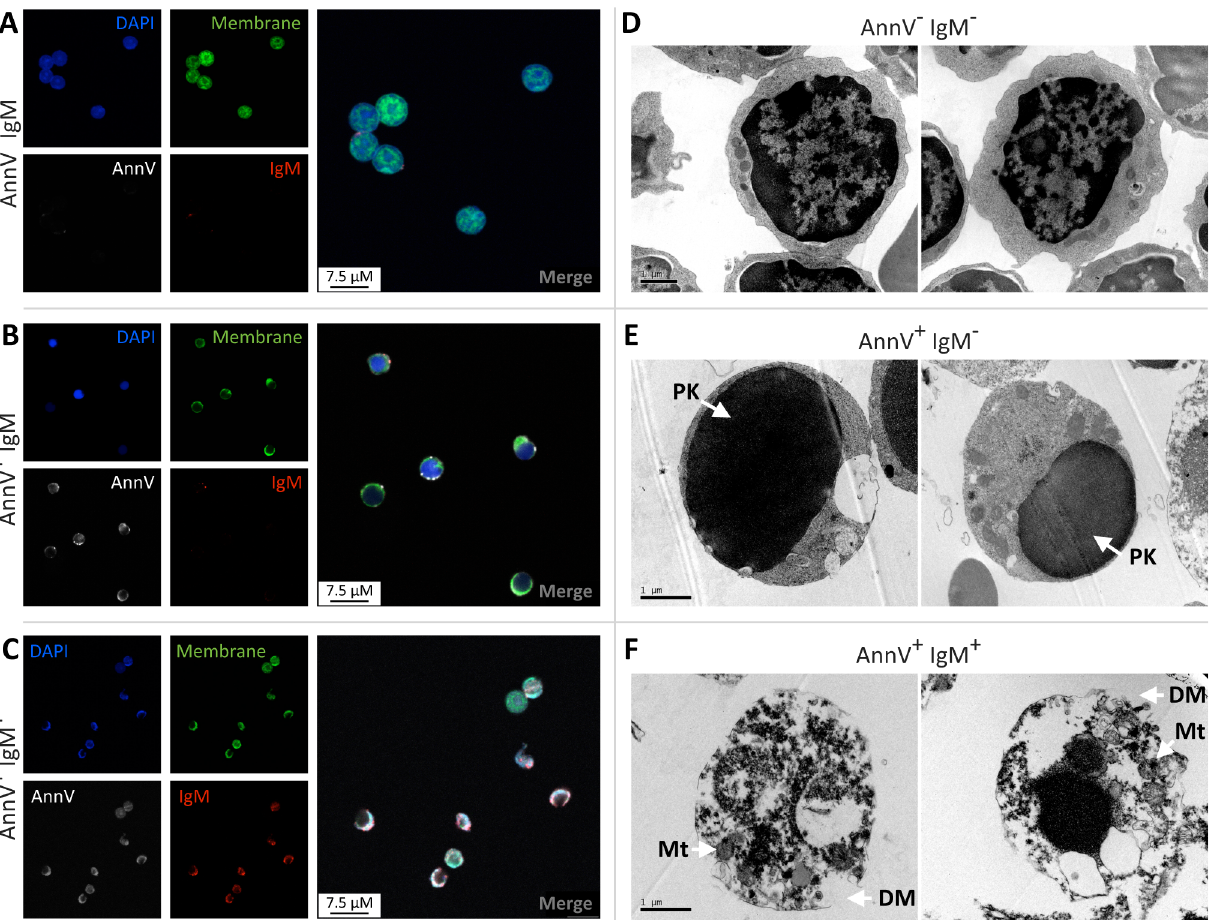
Fig 2. IgM bound mouse apoptotic thymocytes appear disrupted. Mouse thymocytes were stained with a membrane cell tracker and then rendered apoptotic by overnight culture. Thymocytes were then exposed to Balb/c plasma prior to incubation with anti-IgM, Annexin-V (AnnV) and DAPI. On the basis of FSC/SSC thymocytes were then sorted into AnnV - IgM - ( A, D ), AnnV + IgM - ( B, E ) and AnnV + IgM + ( C, F ) populations, as illustrated in Fig 1D, by FACS and examined by confocal or electron microscopy. A ) AnnV - IgM - thymocytes were AnnV and IgM negative. B ) AnnV + IgM - thymocytes exhibited AnnV membrane staining but remained IgM negative and morphologically appeared intact. C ) AnnV + IgM + thymocytes were AnnV positive and appeared disrupted with an apparent IgM + staining. D ) AnnV - IgM - cells appeared non-apoptotic with normal nuclei and intact plasma membranes. E ) AnnV + IgM - cells exhibited nuclear pyknosis (PK, arrowed) with preservation of cytoplasmic and membrane integrity. F ) Electron microscopy studies confirmed that AnnV + IgM + cells had a disrupted membrane (DM, arrowed) with cellular disorganization, but retention of mitochondria (Mt, arrowed). Representative images taken using either a Leica SP5 with an x63/1.4 objective or a Philips CM120 transmission electron microscope with a Gatan Orius CCD camera. Whole image contrast/brightness was adjusted using ImageJ or Adobe